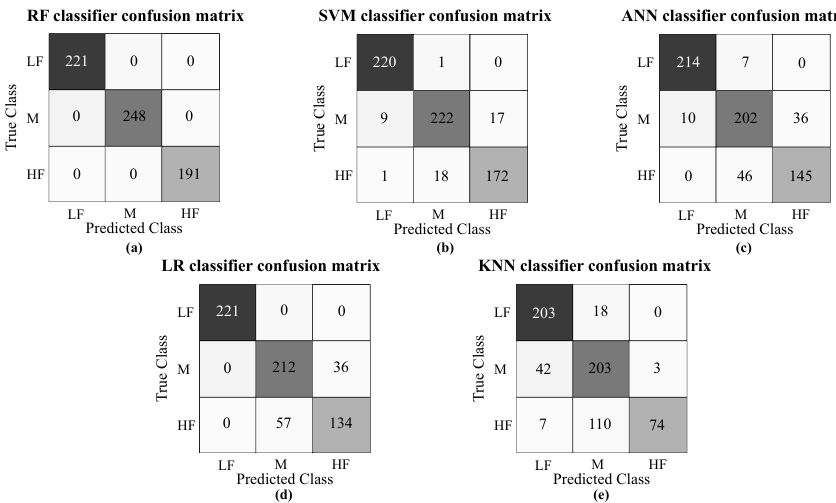
Figure 15. Confusion matrix of ( a ) RF classifier, ( b ) SVM classifier, ( c ) ANN classifier, ( d ) LR classifier, and ( e ) KNN